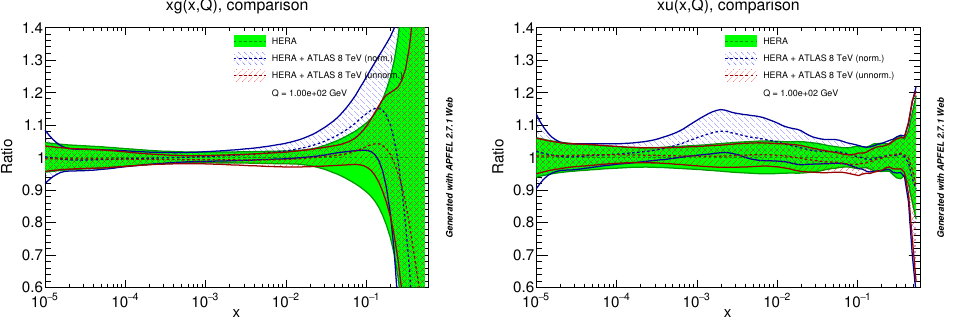
Figure 12 . Impact of the inclusion of normalized versus unnormalized 8 TeV p Z to the HERA-only